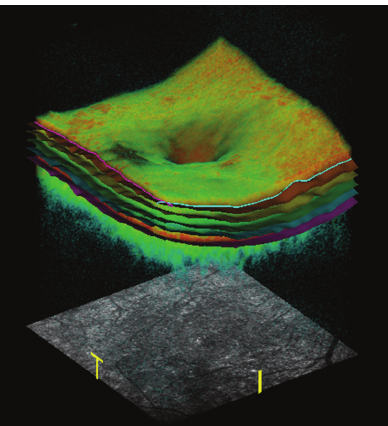
Figure 2: Volume rendering of the macula from the three-dimensional SDOCT data. Segmentation result showing the intraretinal layers.